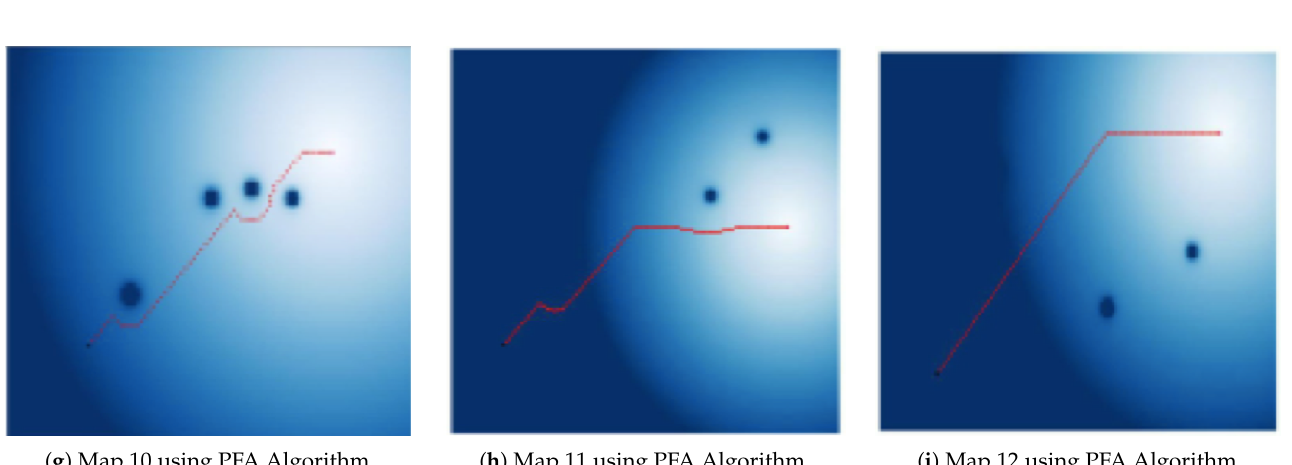
Figure 7. Output of path planning algorithms applied on different reference maps using Google Cloud Computing